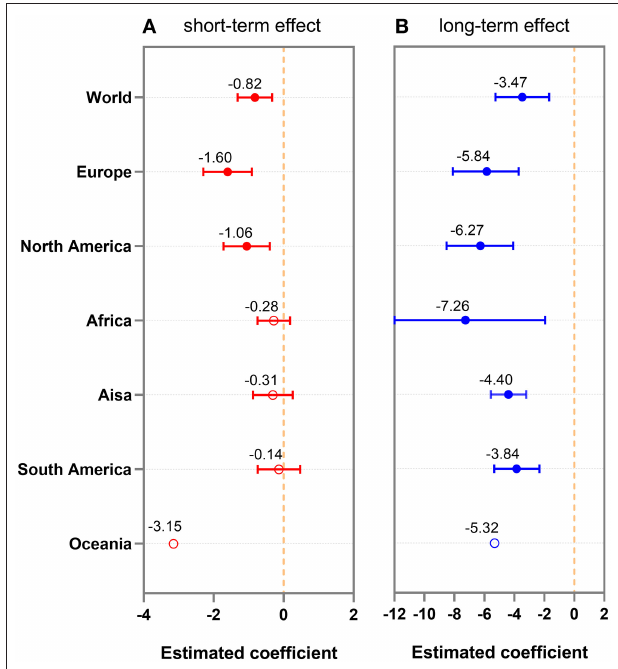
FIGURE 3 | Shot-term (A) and long-term (B) impacts of vaccination on COVID-19 cases among continents. Red circles are filled if the value is significantly different from the null distribution ( p < 0.05), and open otherwise. The number denotes the median, and error bars denote quantiles 0.025 and 0.975. Figures show that vaccine efficacies (VEs) in Europe, North America, and Africa were higher than that in Asia and South America. VEs between countries varied more in Africa (a wider error bar) but were balanced in other continents (a narrower error